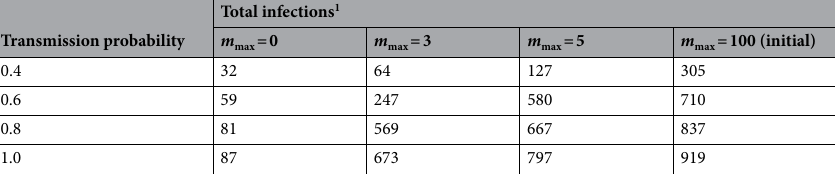
Table 2. Dependency of the number of infections on mobility restriction and detection probability, and transmission probability (1000 people, 2000 sites, 0.6 detection probability, restriction at 1%). 1 Total number of infected people at the end of the simulation.